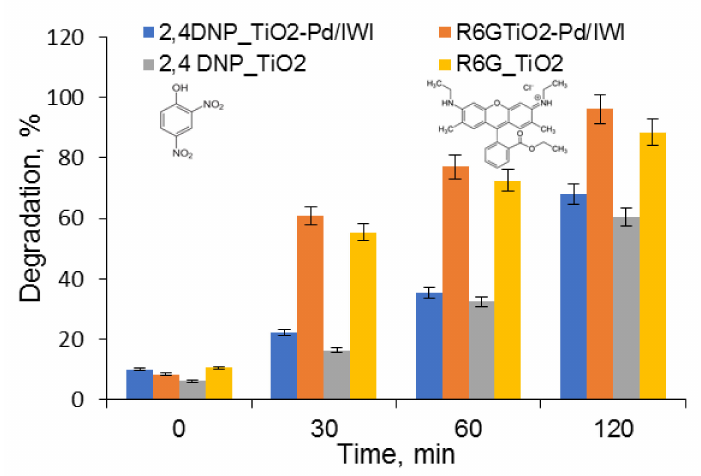
Figure 10. 2,4 DNP and rhodamine 6G (R6G) degradation in the presence of TiO 2 -Pd/IWI and TiO 2 . Experimental conditions: photocatalyst dose = 1g/L; pollutant = 20